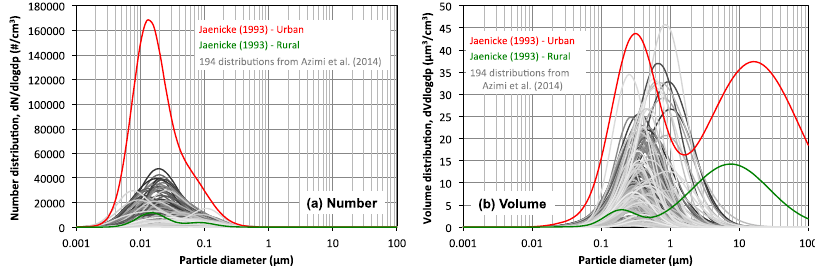
Figure 2. Trimodal ( a ) number and ( b ) volume distributions for 194 long-term outdoor particle size distributions across the world (from Azimi et al., 2014 [29]) overlaid with the urban and rural ambient distributions from Jaenicke (1993) [31].